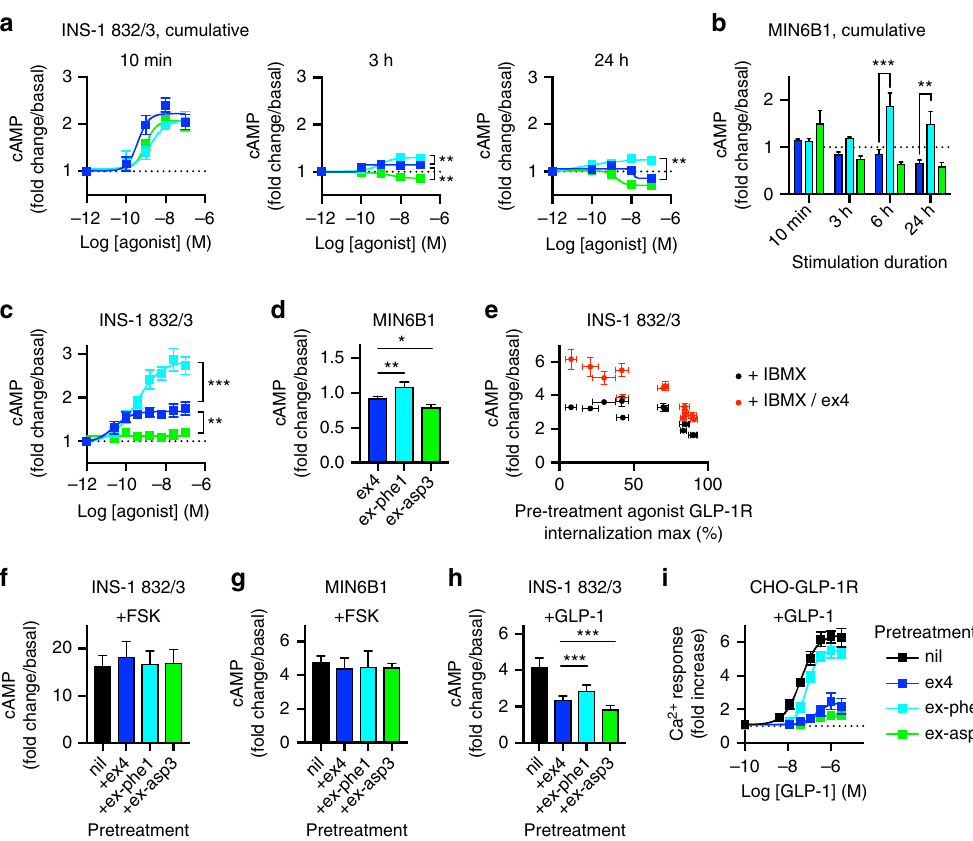
Fig. 3 Prolonged cAMP generation in beta cells. a cAMP measurement in INS-1 832/3 cells in response to continuous agonist exposure for indicated times. Incubations performed in the presence of 25 µ M IBMX and the results expressed relative to IBMX-only response for each time-point, n = 4, one-way randomized block ANOVA comparing E max with Dunnett ’ s test vs. exendin-4. b As in a , but with 100 nM agonist in MIN6B1 cells, n = 3, two-way randomized block ANOVA with Dunnett ’ s test vs. exendin-4. c cAMP accumulation dose response in INS-1 832/3 cells at the end of the 16 h